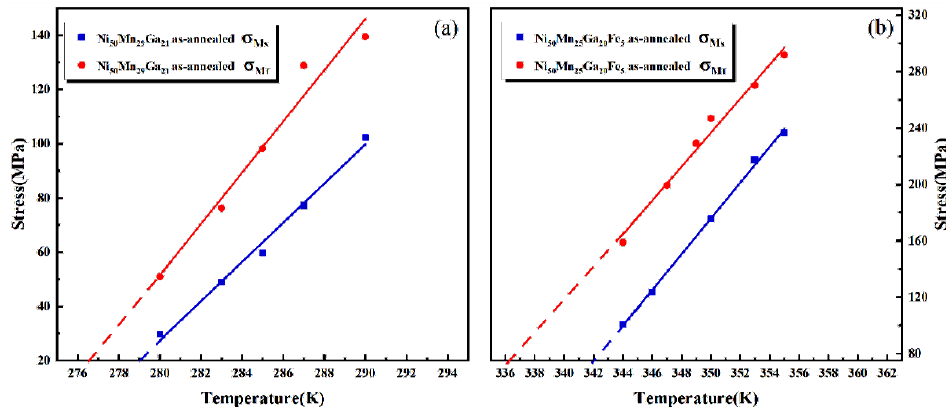
Figure 5. ( a )Critical stress-temperature curves for Ni 50 Mn 29 Ga 21 microwires, ( b ) Critical stress-temperature curves for Ni 50 Mn 25 Ga 20 Fe 5 microwires.